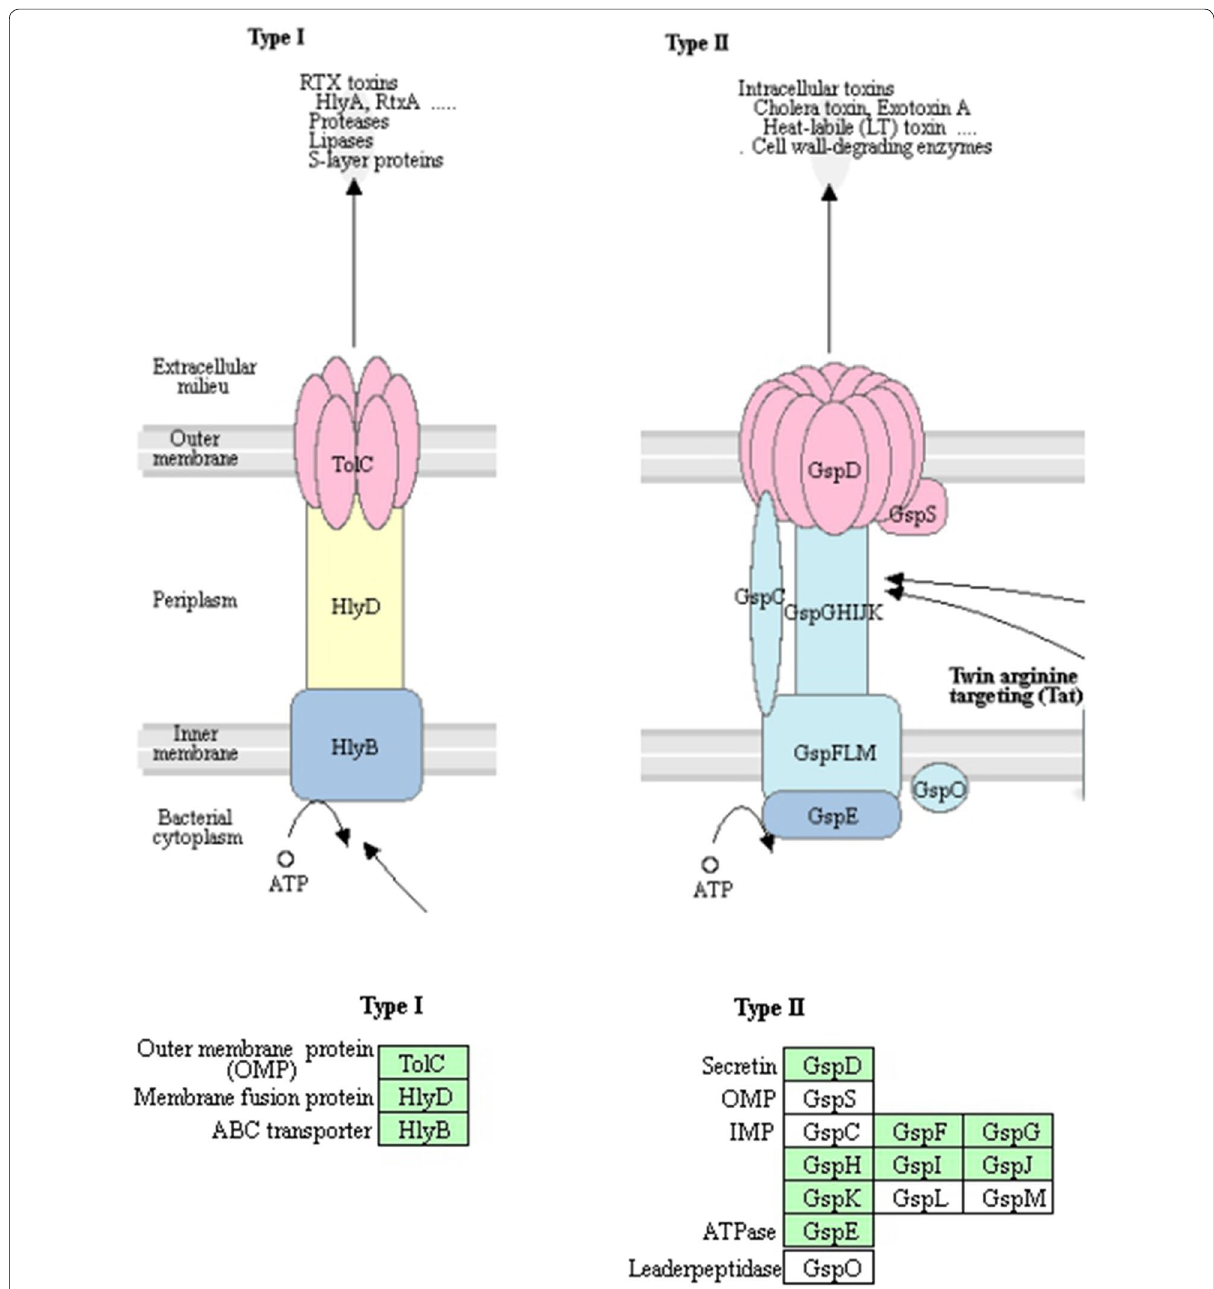
Fig. 5 KEGG pathway of the genes HlyB , GspE , GspF of Burkholderia multivorans WS‑FJ9 (Bacterial secretion system (T1SS,